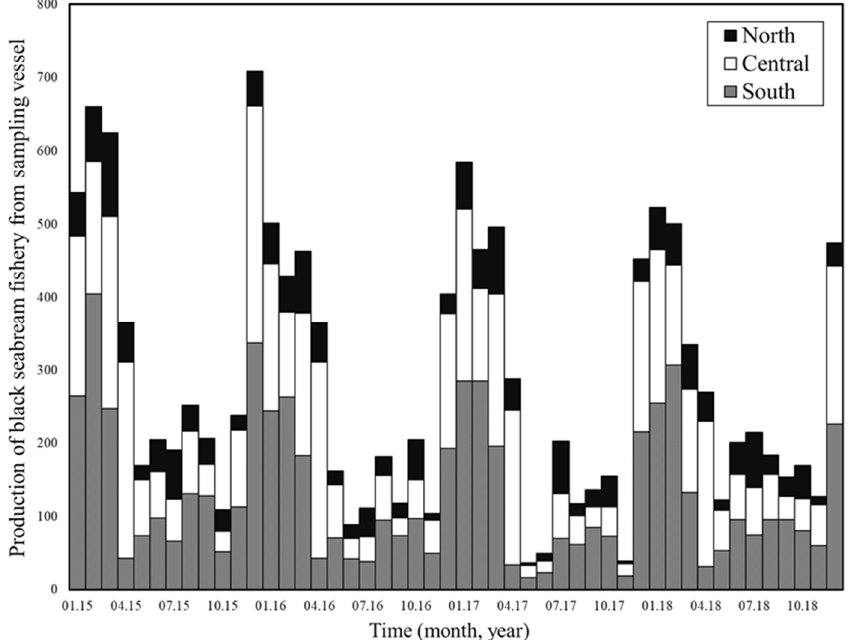
Figure 2. Monthly production of black sea bream from coastal and offshore fisheries in waters off western Taiwan from 2015 to 2018.